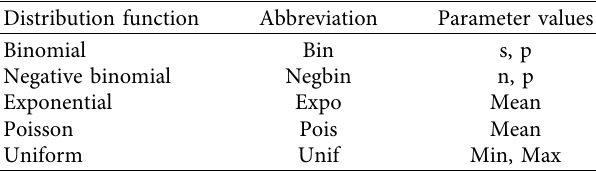
Table 1: Probability distributions and their parameter values.